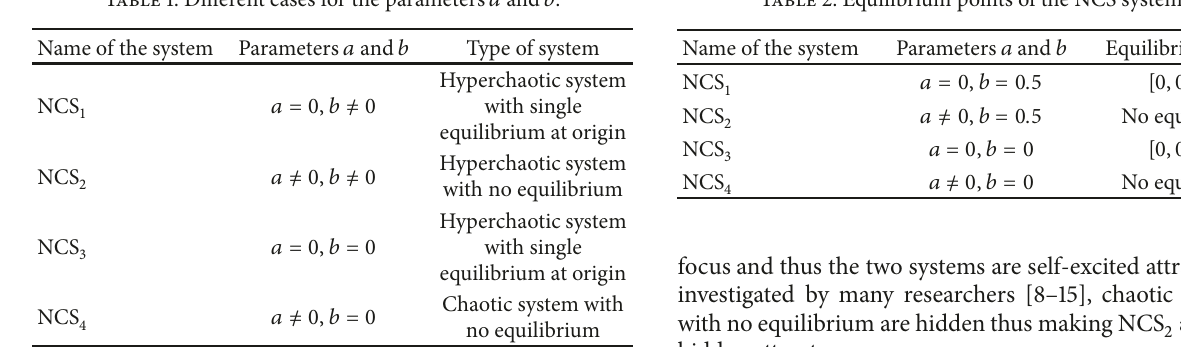
Table 2: Equilibrium points of the NCS